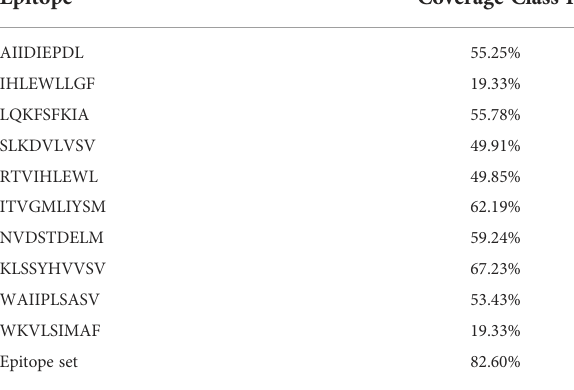
TABLE 2 Individual world population coverage of selected MHC-I epitopes.